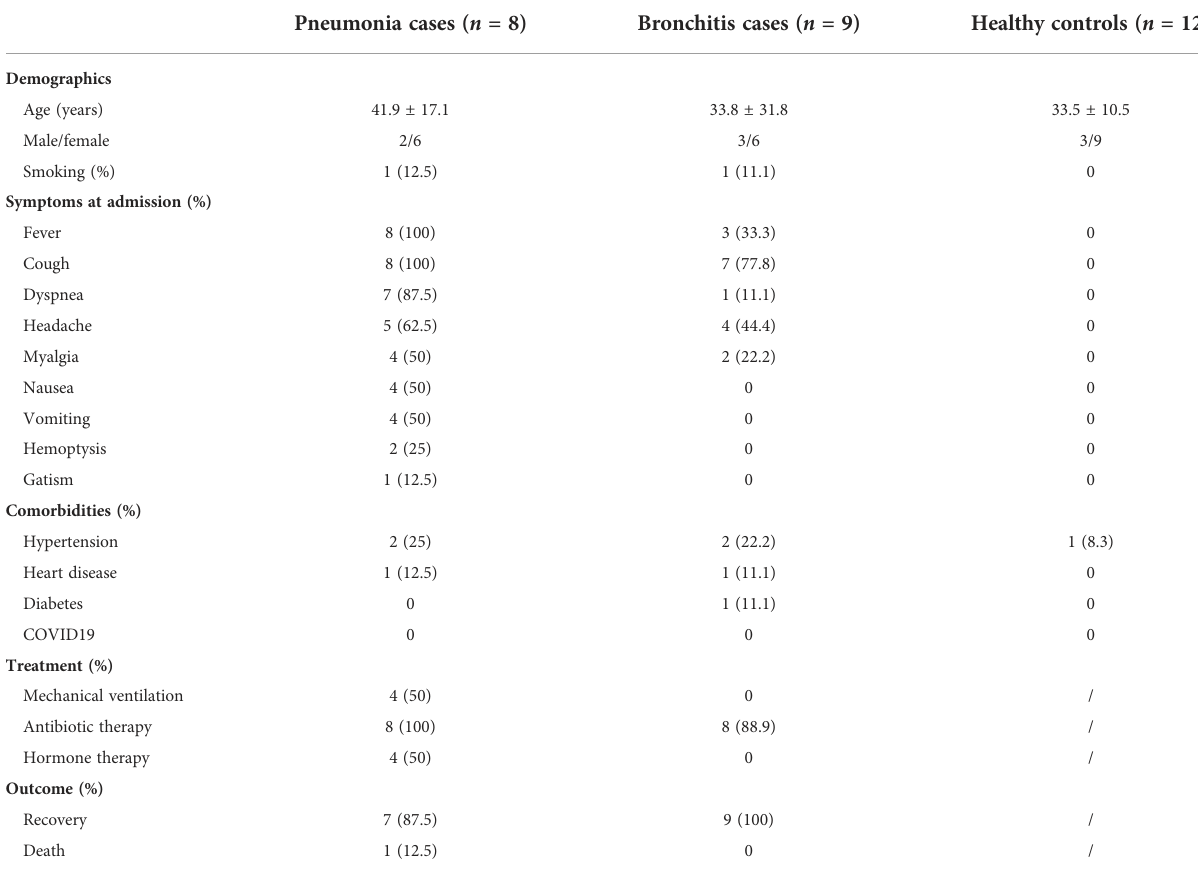
TABLE 1 Clinical characteristics of the psittacosis groups and